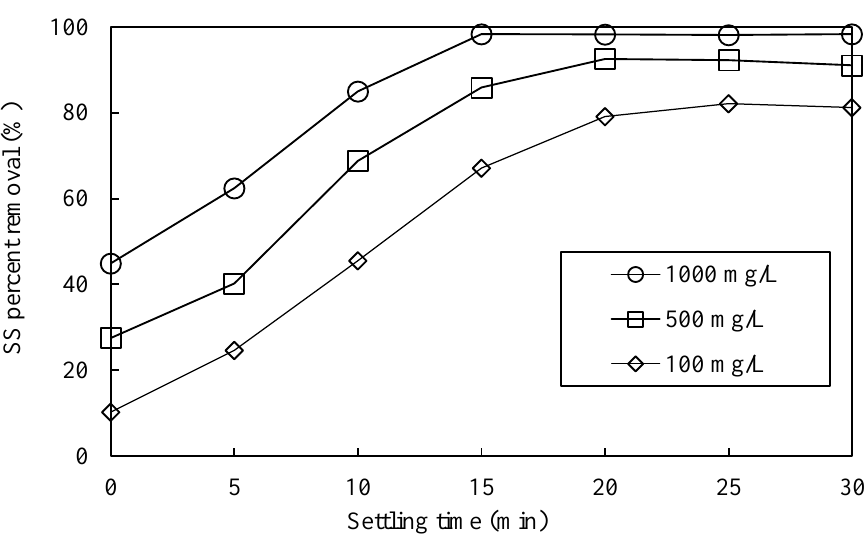
Figure 6. Percent removal of SS in kaolin suspensions after different settling period times.